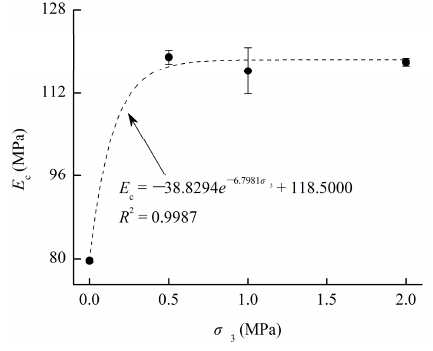
Figure 6. Relationship between the deformation modulus and confining pressure under a Talbot index of 0.4.